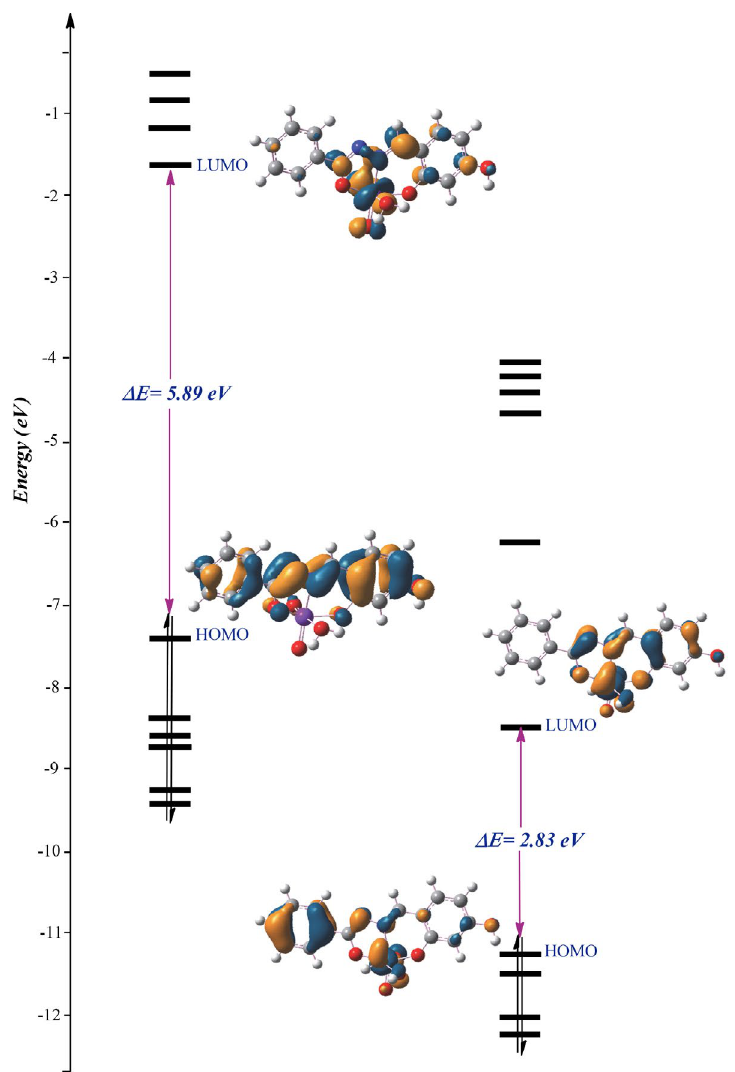
Figure 2. Frontier molecular orbital (FMO) diagram of complex 1 (left) and complex 2 (right)